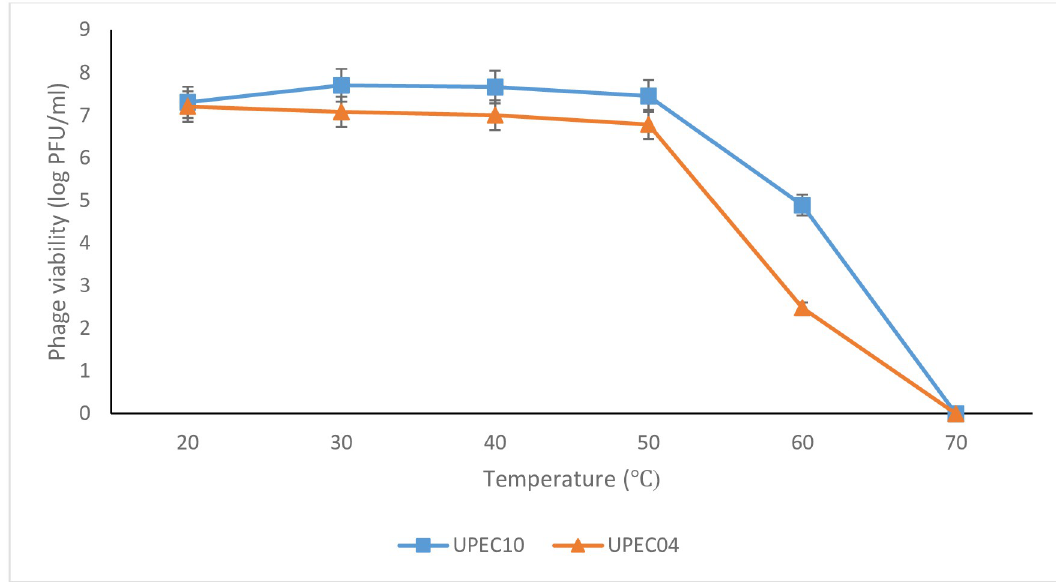
Fig 4. Effect of temperature on UPEC04 and UPEC10 phage viability. Phage viability was determined by obtaining the phage titers at the different temperatures using the agar overlay method. Values are an average for duplicate tests.